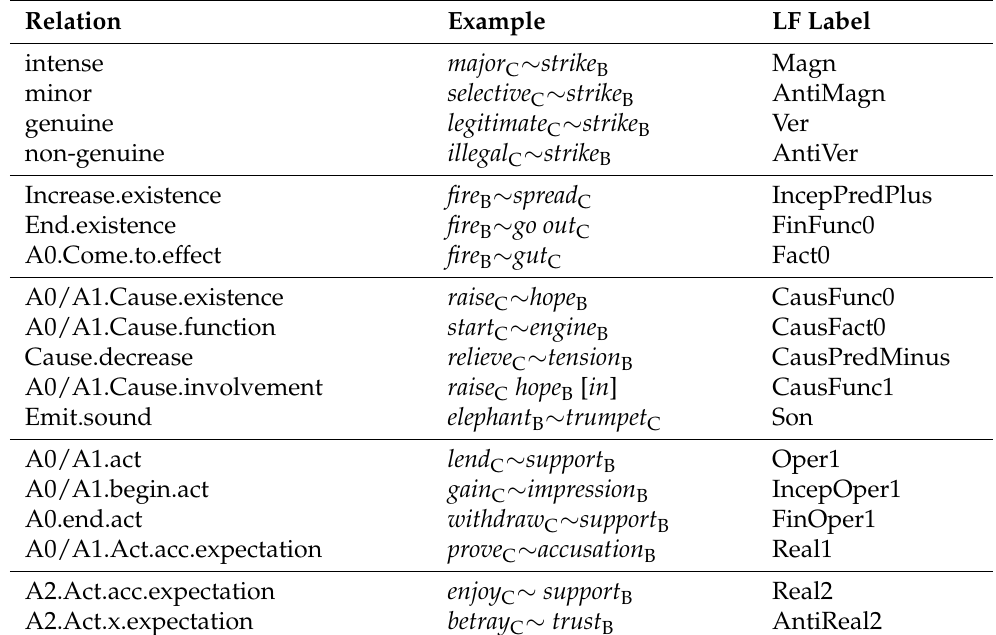
Table 1. LF relations used in this paper. ‘A i ’ refers to AMR argument labels